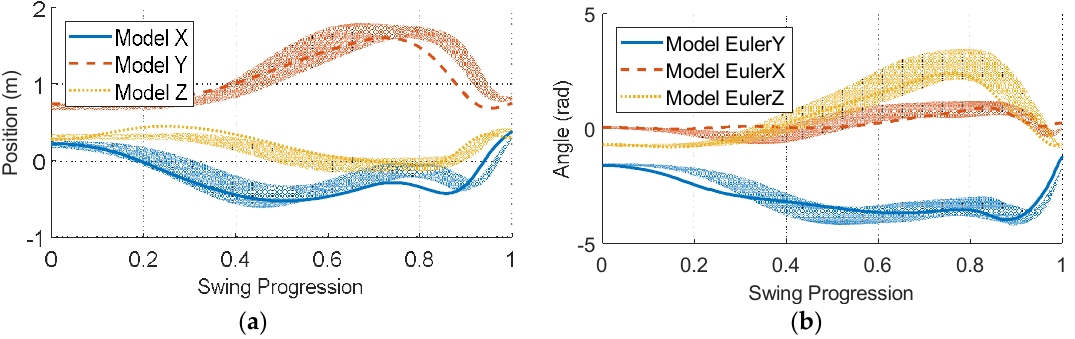
Figure 3. Comparison of simulated and experimental grip kinematics from elite golfers. ( a ) Grip position; ( b ) Grip orientation defined by Y-X-Z Euler rotations. The shaded bands represent one standard deviation of the measured kinematics for the ten elite golfers (100 golf swings